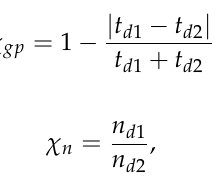
Figure 2. The distributions of the normalized electric field 𝑅𝑒(𝐸 (cid:3052) ) and normalized intensity 𝐼 ∝ (cid:3627)𝐸 (cid:3052) (cid:3627) (cid:2870) as well as filling factors ( 𝐹𝐹 ) of two exemplary waveguide grating geometries with 𝑡 (cid:3031)(cid:2869) + 𝑡 (cid:3031)(cid:2870) = 0.632 𝜆 , 𝑡 (cid:3034) = 0.079 𝜆 , 𝑛 (cid:3046) = 1.0 , 𝑛 (cid:3031)(cid:2869) = 𝑛 (cid:3031)(cid:2870) = 1.5 ( 𝜒 (cid:3041) = 1.0) and 𝑛 (cid:3034)(cid:2869) = 𝑛 (cid:3034)(cid:2870) = 1.275 : ( a ) TE 0 mode at 𝜒 (cid:3034)(cid:3043) = 0 ; ( b ) TE 1 mode at 𝜒 (cid:3034)(cid:3043) = 0.0 ; ( c ) TE 1 mode at 𝜒 (cid:3034)(cid:3043) = 1.0 ; ( d ) TE 1 mode at 𝜒 (cid:3034)(cid:3043) = 1.0 .